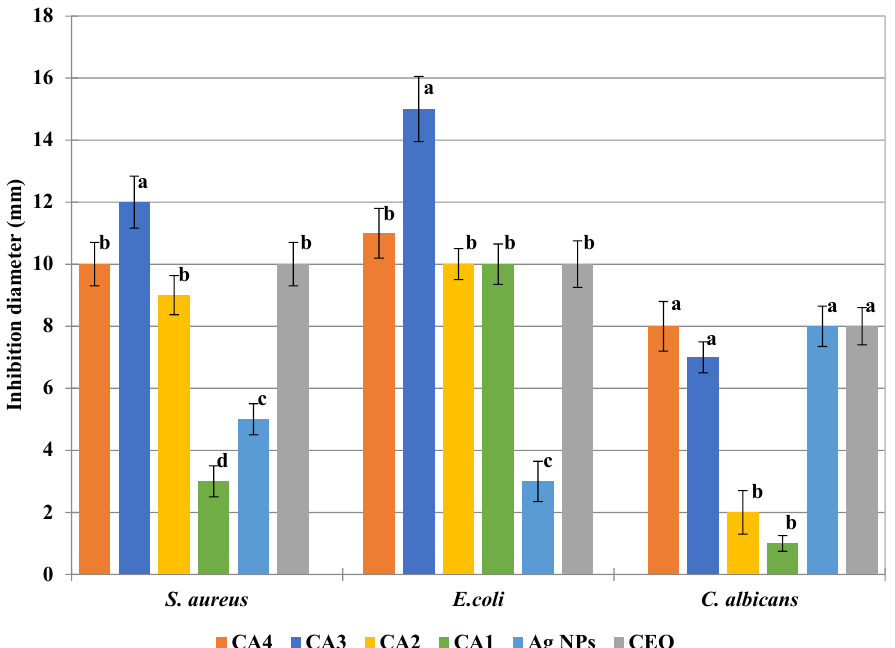
Figure 16. The antimicrobial activity of CA1–CA4 films and CEO—different letters indicate statistically significant differences between films ( p < 0.05).